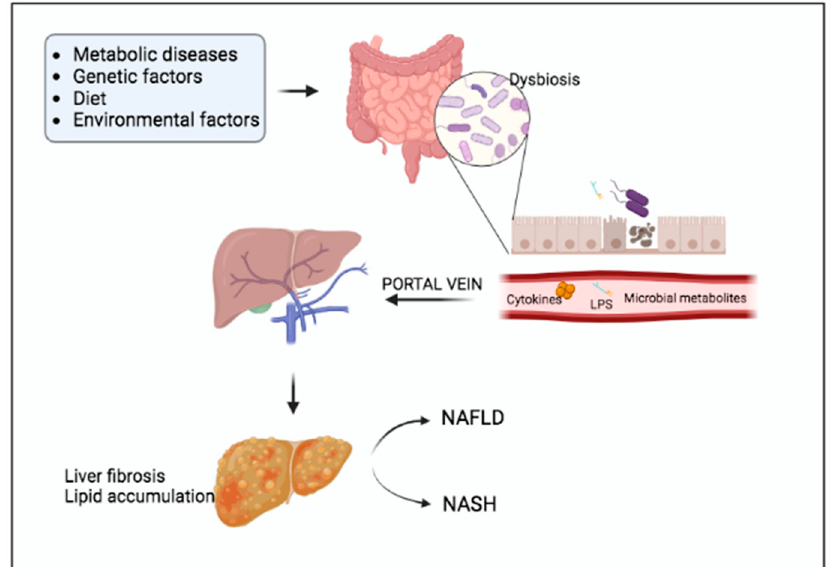
Figure 3. The gut microbiota dysbiosis induces NAFLD progression. The gut microbiota alterations associated with metabolic, genetic or environmental factors play key roles in liver disorders. Dysbiosis increases gut permeability, favors LPS translocation and promotes pro-inflammatory cytokines production, thus participating to liver fibrosis and NAFLD occurrence.